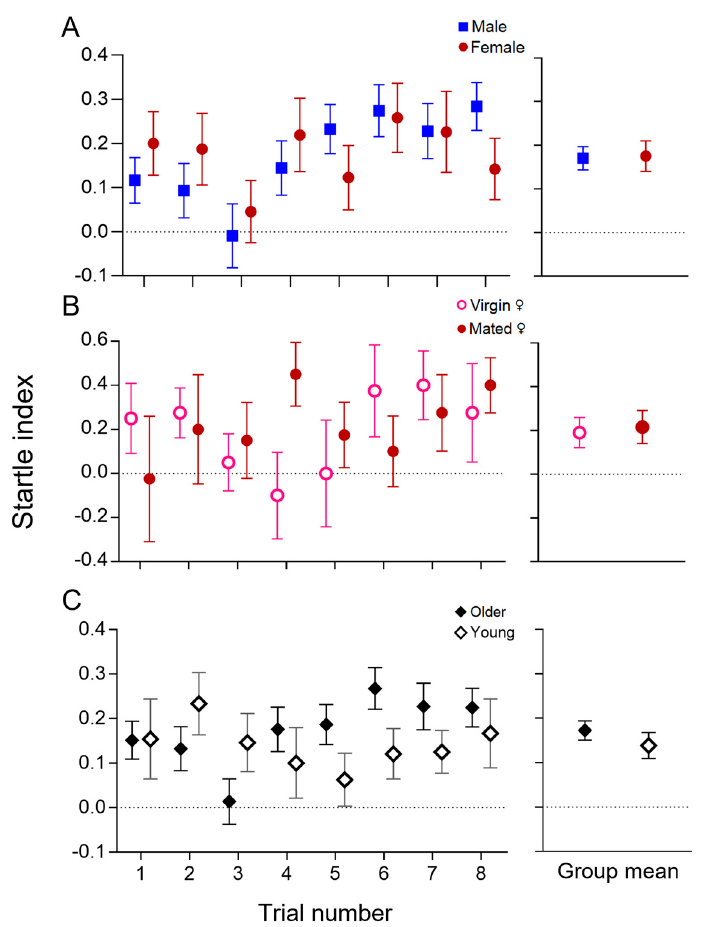
Figure 2. Motor response to lights-off stimuli for different conditions. ( A ). Adult flies tested previously (Figure 1D) were separated into male and female groups for assessment of possible sex differences. No significant distinctions among sexes were found (two-way ANOVA, p sex = 0.985, p trials = 0.012, p interaction = 0.467, n = 43 males/31 females). Both sexes’ 8-trial averages showed a signi fi cant movement increase after stimuli (one-sample t-test against 0, p < 0.0001 for both groups). ( B ). E ff ects of mating were tested by collecting same-age virgin and mated females. Similarly, no di ff erences in response were found (two-way ANOVA, p mating = 0.809, p trials = 0.751, p interaction = 0.361, n = 8/group). Group averages also showed a signi fi cantly increased motor response (one-sample t -test, p = 0.027